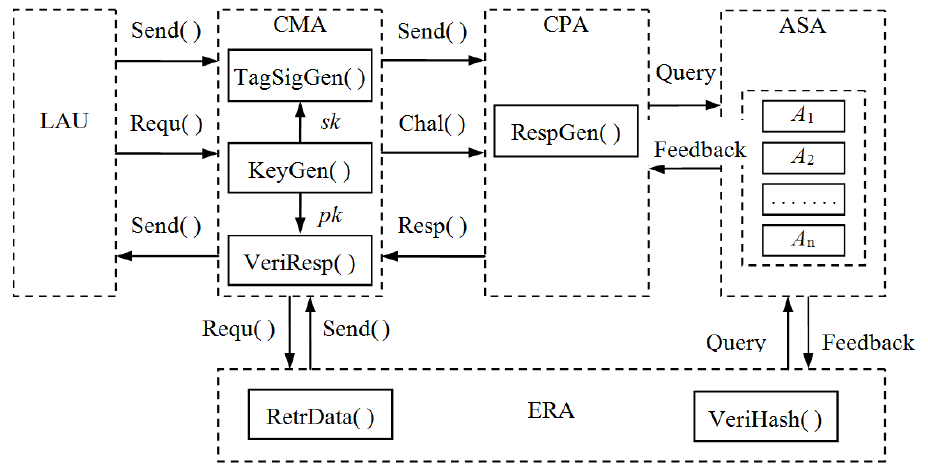
Figure 2. The workflow of five functional areas. “Send( )” means that the sender sends the evidence file to the receiver; “Requ( )” means that the sender sends the request message to the receiver; “Chal( )” means that one side sends the challenge message to the other side; “Resp( )” means that one side sends the response values to the other side; “Query” means that the CPA or the ERA queries chunks of the ASA; “Feedback” means that the ASA gives feedback messages of chunks and